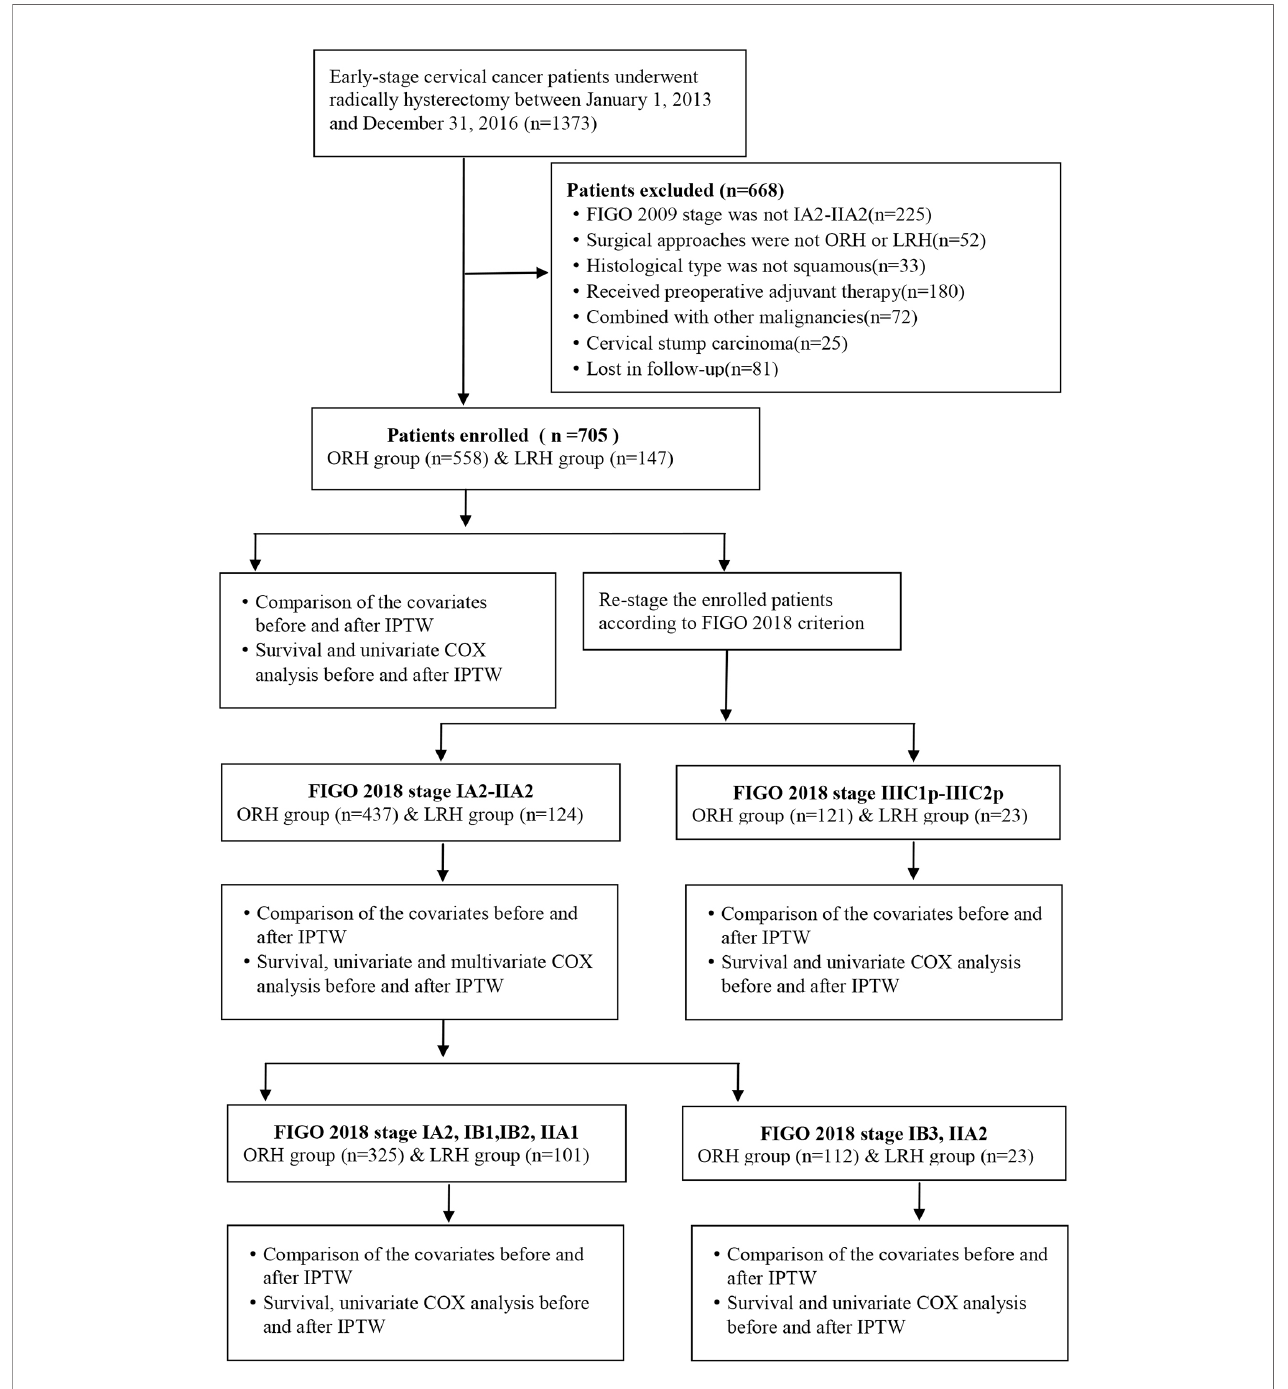
FIGURE 1 | Work fl ow of patient inclusion and statistical